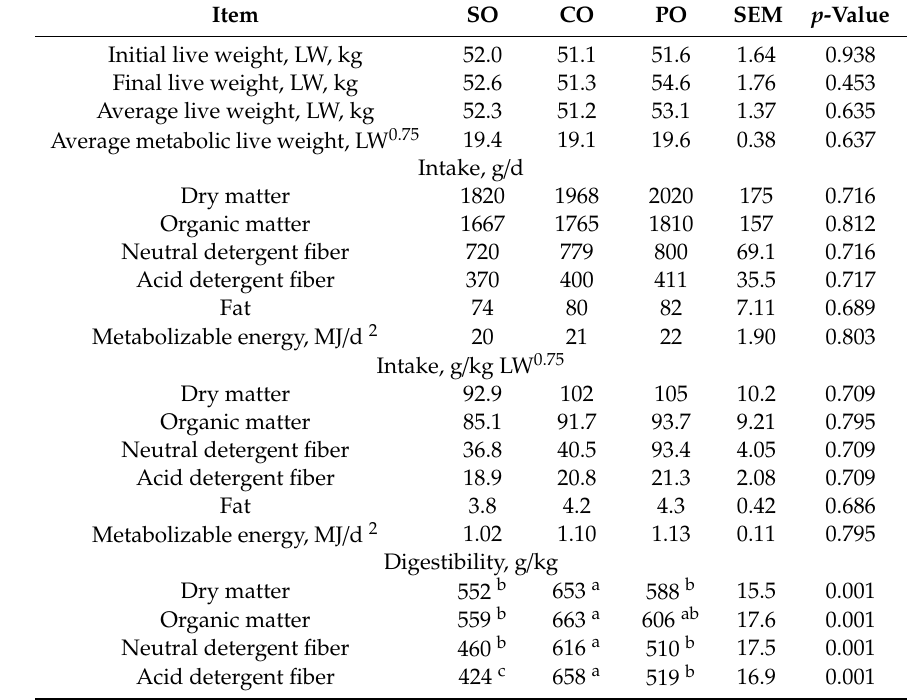
Table 3. Nutrient intake and digestibility of goats supplemented with sa ffl ower oil (SO), canola oil (CO) and palm oil (PO) treatments 1